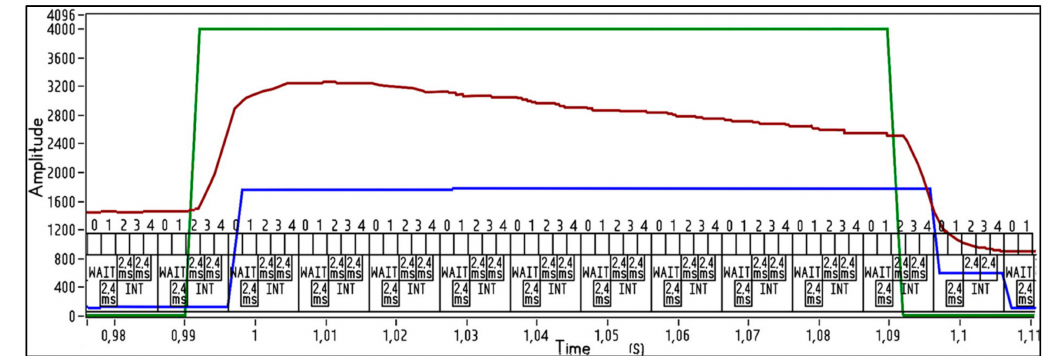
Figure 6. Alignment of the ECG and PPG Clear signals with the test impulse. Digits from 0 to 4 shows the numbers of times the ECG signal is sampled in 10